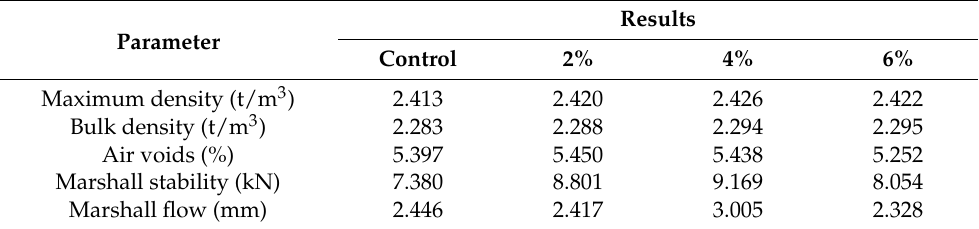
Table 11. Marshall testing methods results.